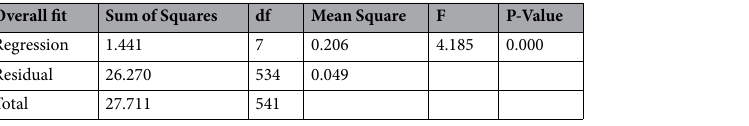
Table 2. Fit of the model for overall population. Adjusting for age, gender, ethnicity, BMI, Tanner stage, batch effect.